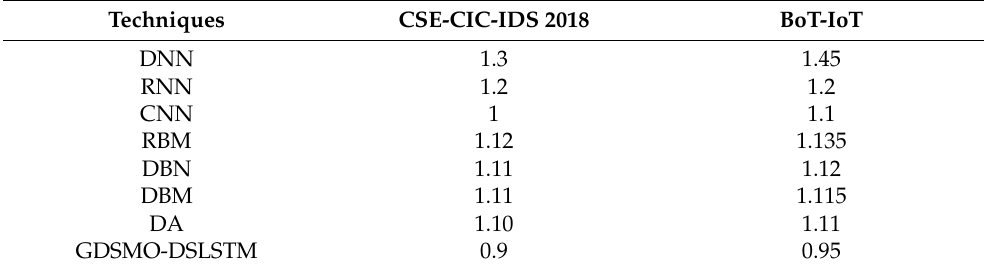
Figure 19. FAR of existing and proposed deep learning mechanisms for both the CSE-CIC-IDS 2018 and BoT-IoT datasets.